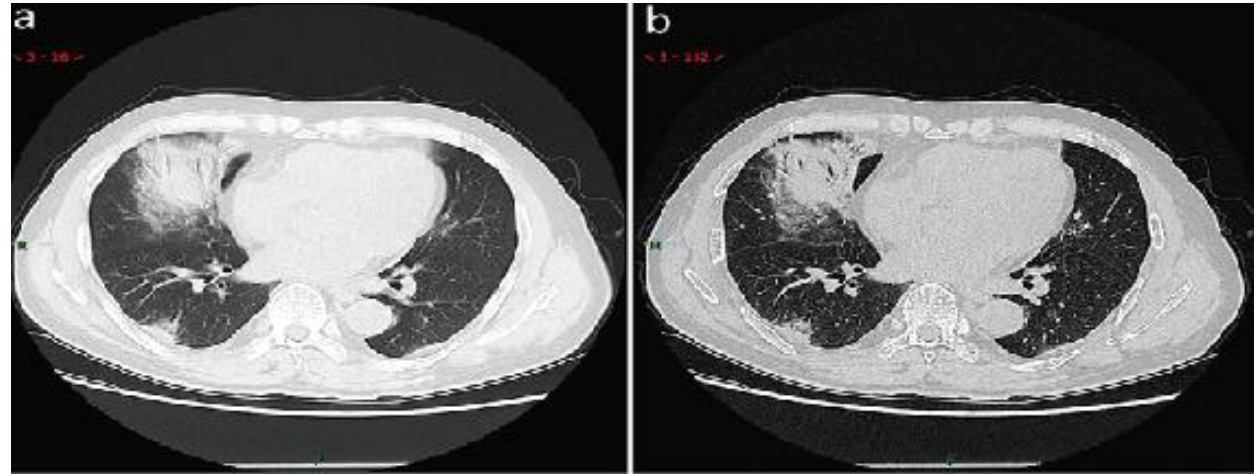
Figure 9: CT imaging of consolidation stage. A 65 years old male with fever (maximum temperature of 39 ℃). Laboratory test: hypoproteinemia (decreased total protein (62.20 g/L), decreased albumin (35.70 g/L)), abnormal liver function (increased alanine aminotransferase (79 U/L), increased aspartate aminotransferase (72 U/L)), increased procalcitonin (0.10 ng/ml), increased C- reaction protein (53 mg/L), decreased white blood cells (3.72 × 10 9 /L), decreased lymphocytes (0.9 × 10 9 / L), mildanemia (decreased red blood cells (4.10 × 10 12 /L), decreased hemoglobin (131.10 g/L), decreased hematocrit (39.0%). Imaging examination: a (thin layer CT) and b (high-resolution CT) showedmultiple patchyand large consolidation in right middle lobe, posterior and basal segment of right lower lobe and outer and basal segment of left lower lobe, with air-bronchogram